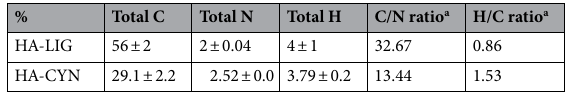
Table 1. Elemental composition (%) of HA-LIG and HA-CYN. a Atomic